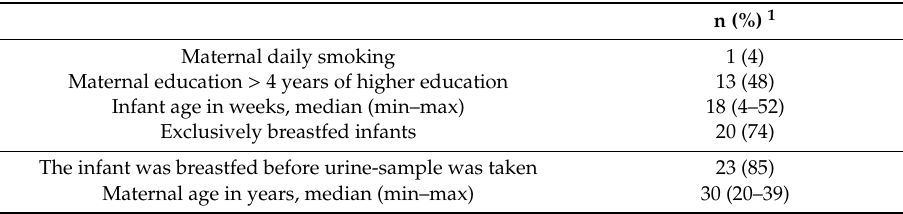
Table 1. Characteristics of included mother-infant dyads n = 27.